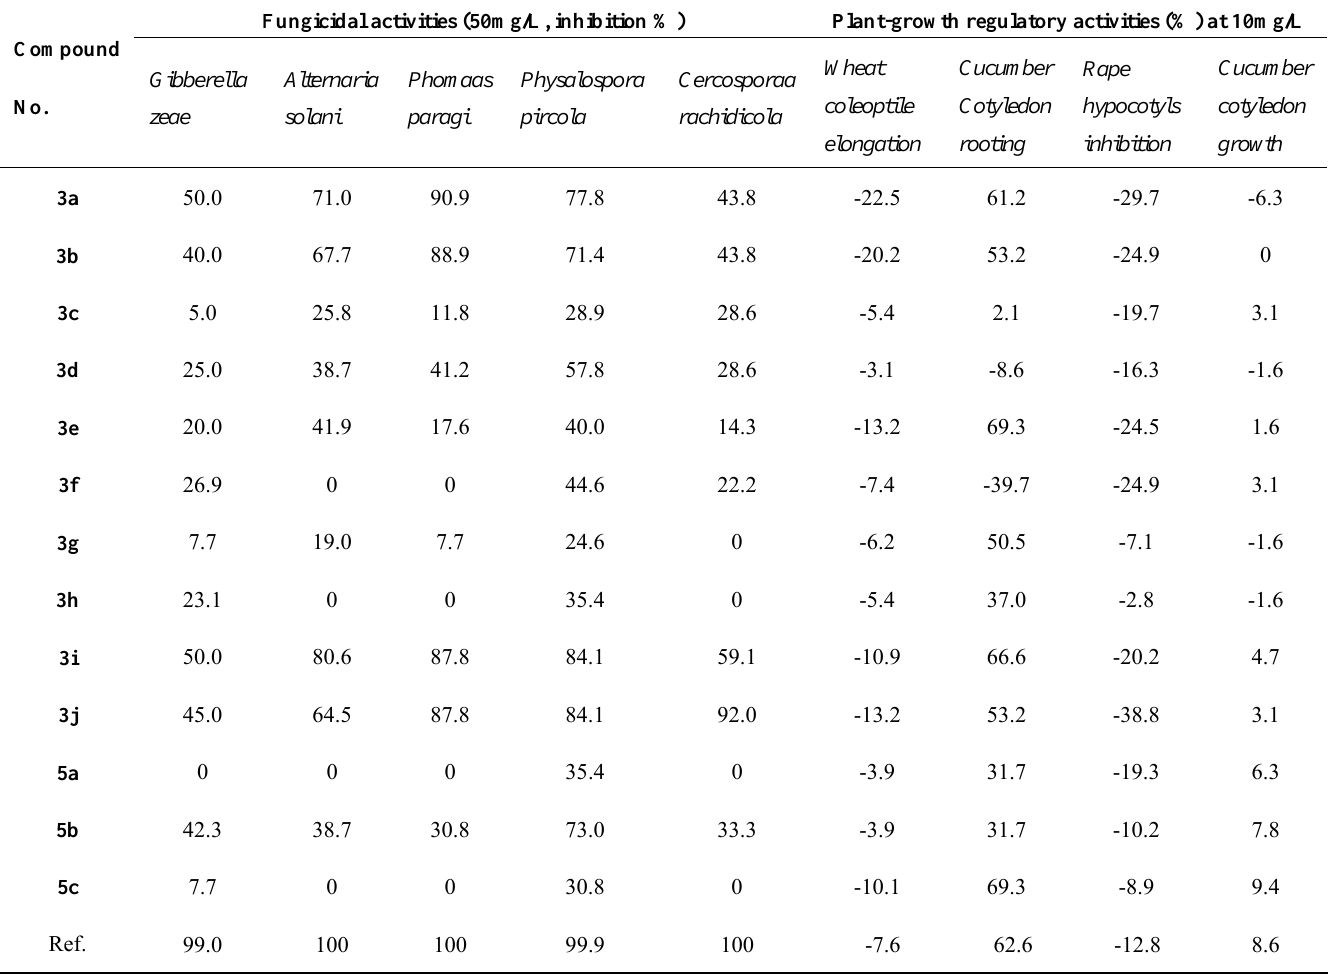
Table 1. The fungicidal and plant growth regulatory activities of compounds 3 and 5 Fungicidal activities (50mg/L, inhibition